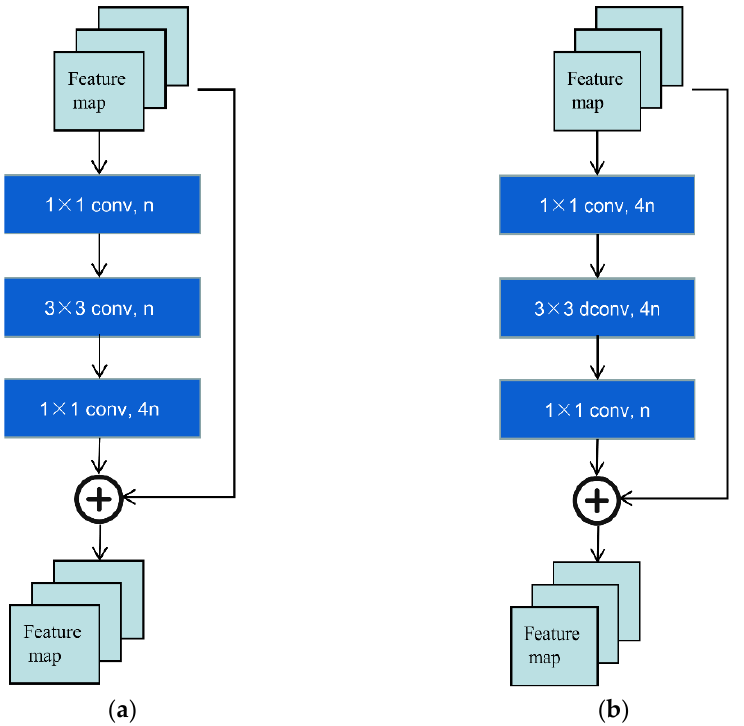
Figure 3. ( a ): residual block ( b ): inverted residual block, n means channel numbers.